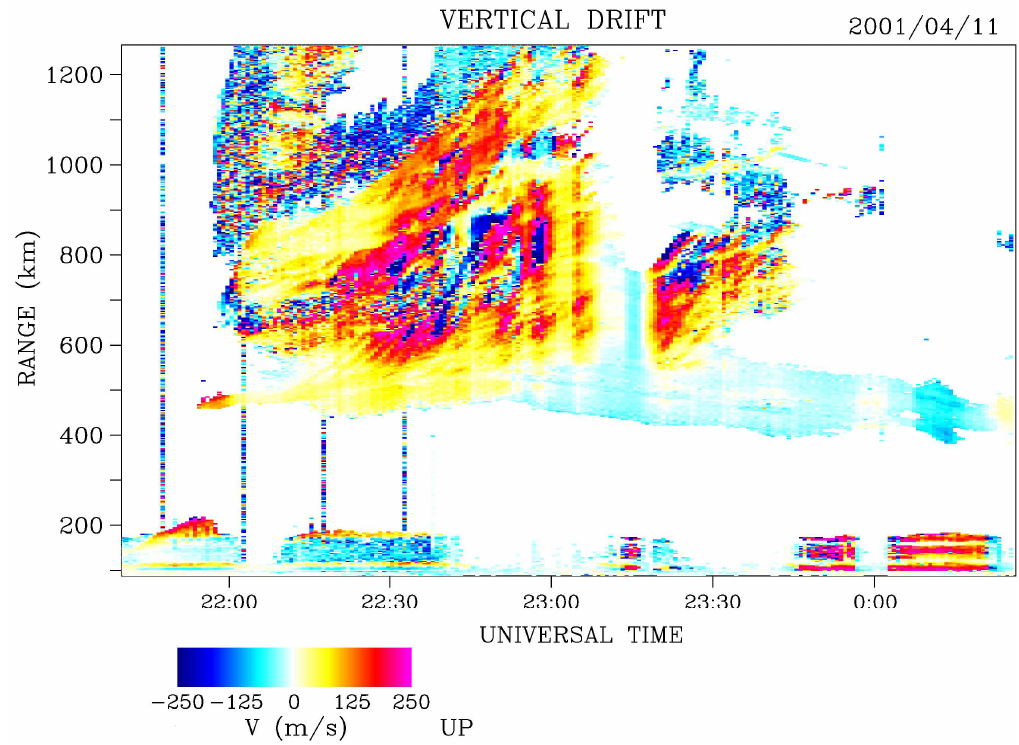
Fig. 3b. VHF radar vertical velocity plot of the echoes from the ionospheric irregularities for the storm night of 11–12 April